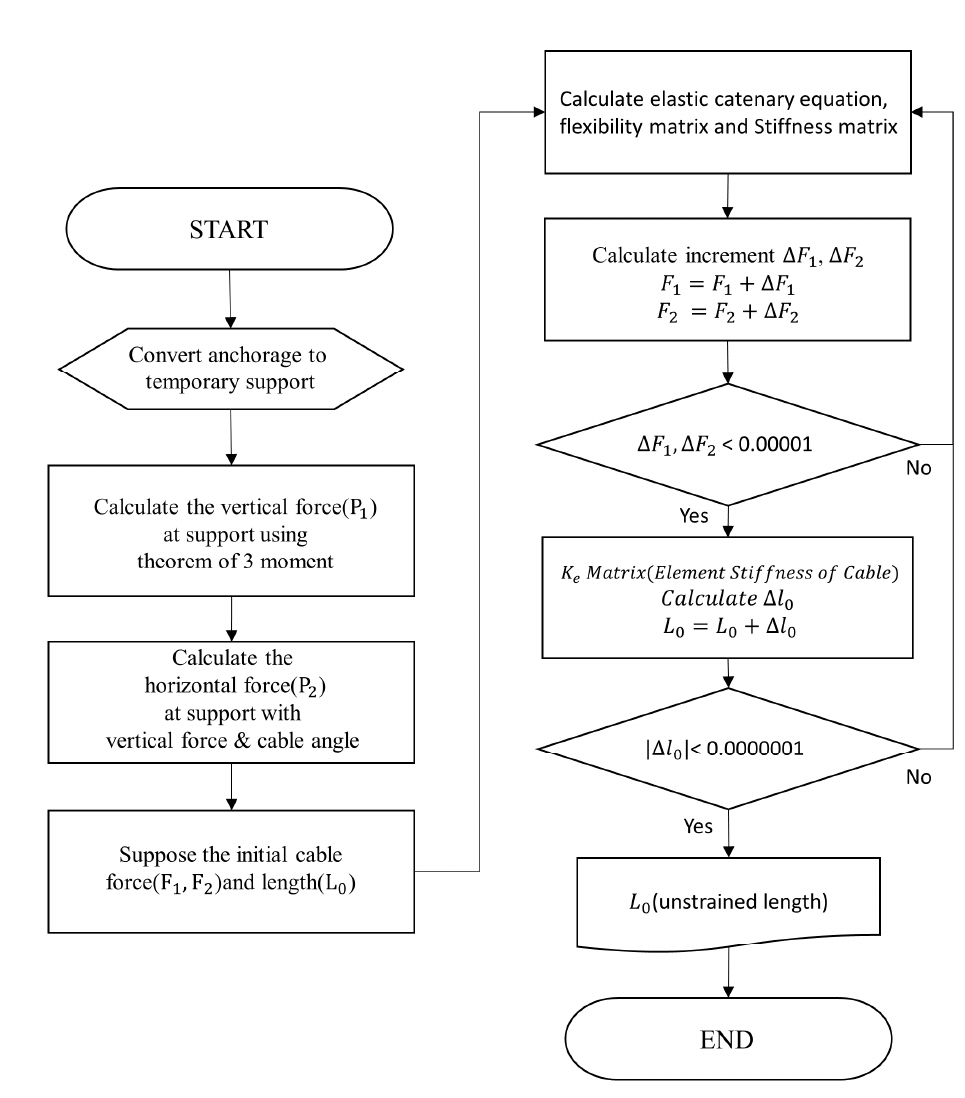
Figure 13. Flow chart for initial equilibrium state of cable-supported bridges.